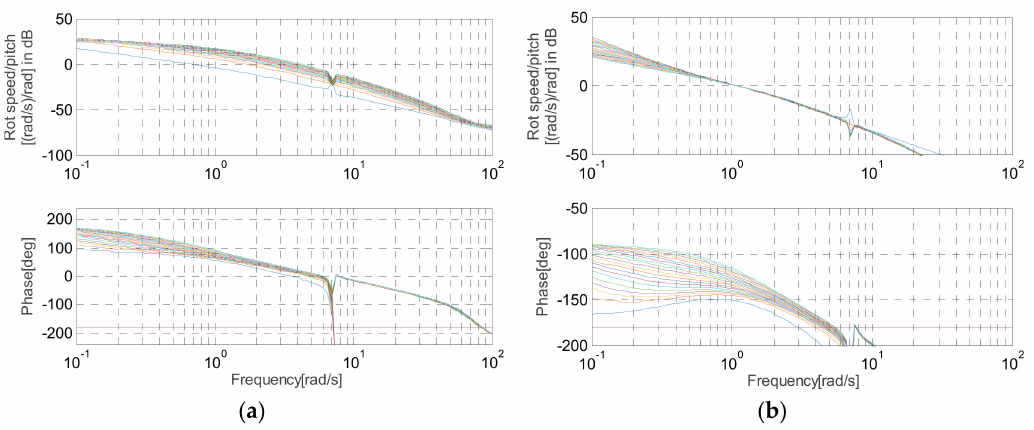
Figure 6. Frequency response of the pitch loop. ( a ) Open-loop transfer function for the pitch input; ( b ) pitch control loop gain transfer function with gain scheduling.